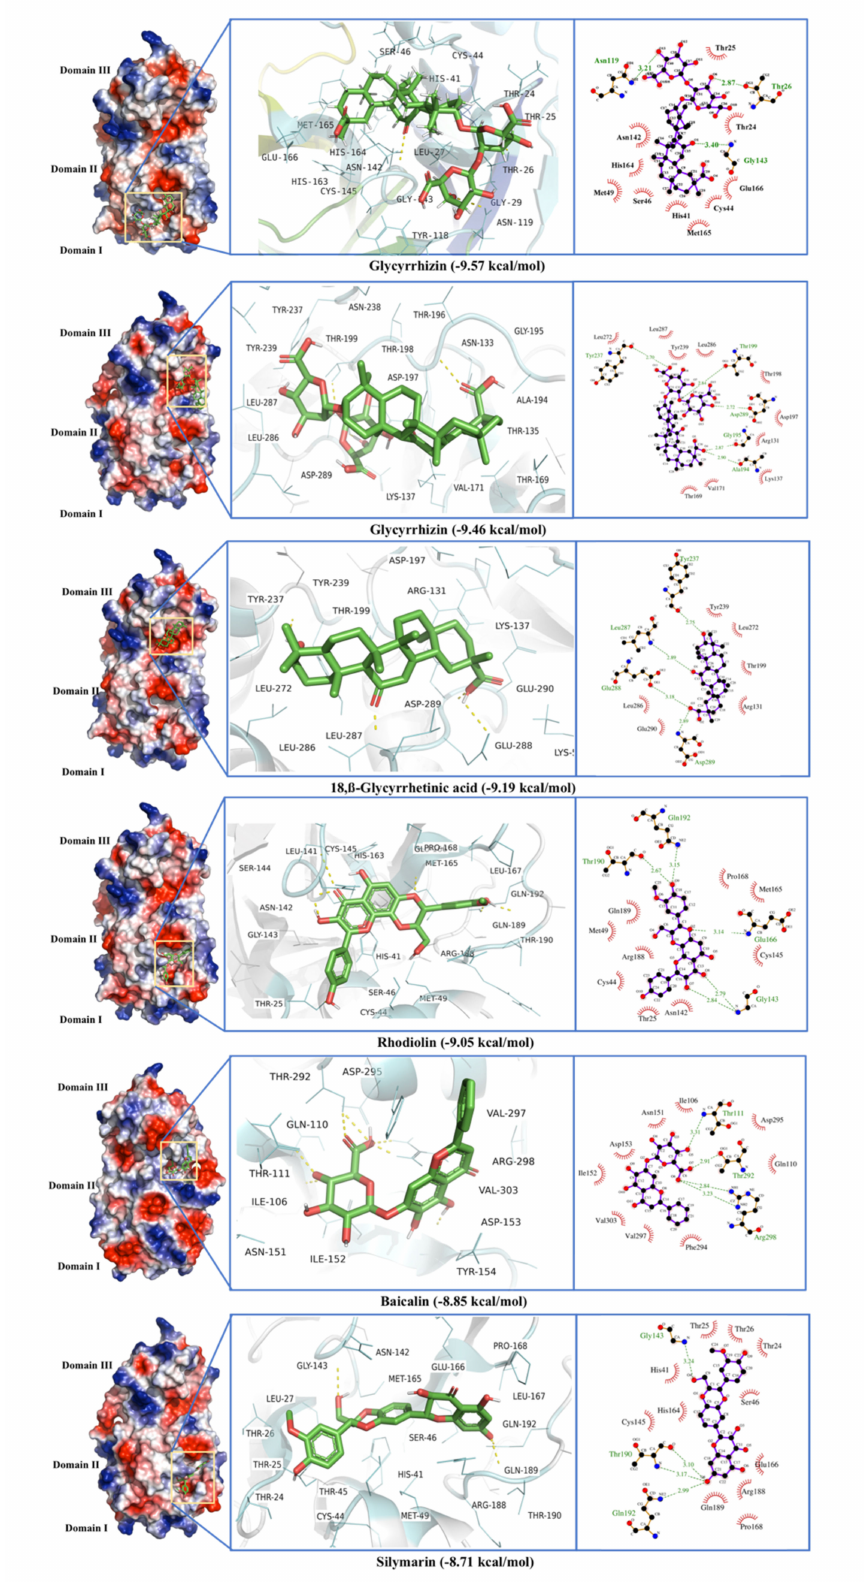
Figure 2. Molecular docking of Glycyrrhizin, 18, β -Glycyrrhetinic acid, Rhodiolin, Baicalin, and Silymarin with SARS-CoV-2 main protease